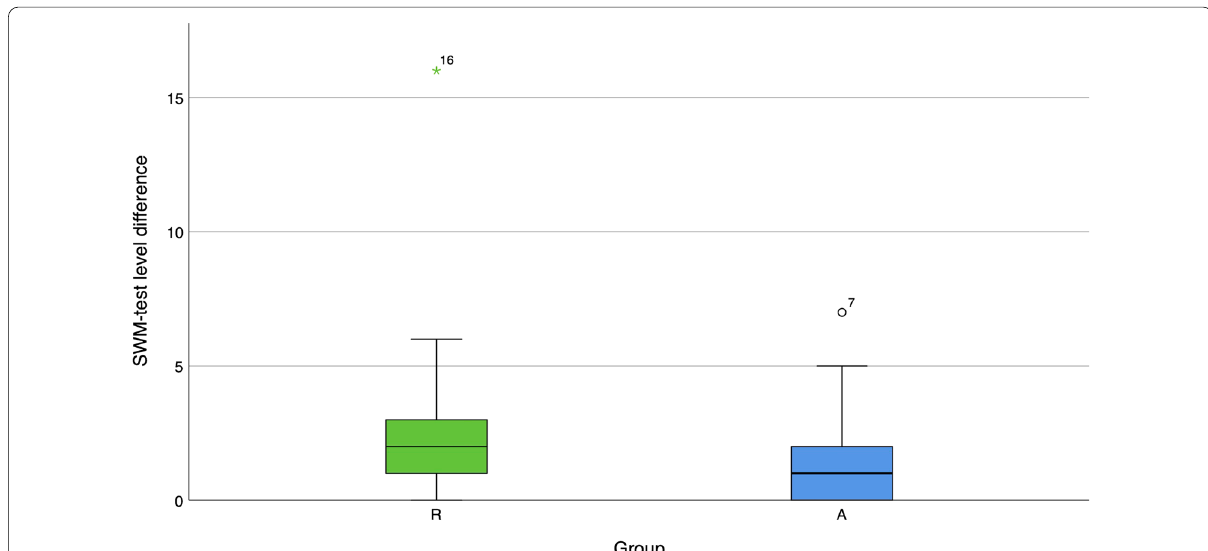
Fig. 5 Boxplots comparing the Semmes–Weinstein monofilament level difference between the injured and uninjured sides in groups R and